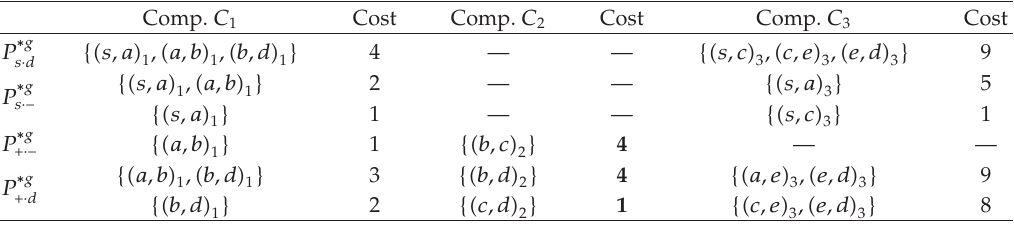
Table 2: Best intra component paths recalculated for graph in Figure 1 if the cost of arc (cid:5) b,c (cid:6) from two to four. Recalculated paths are shown in bold.